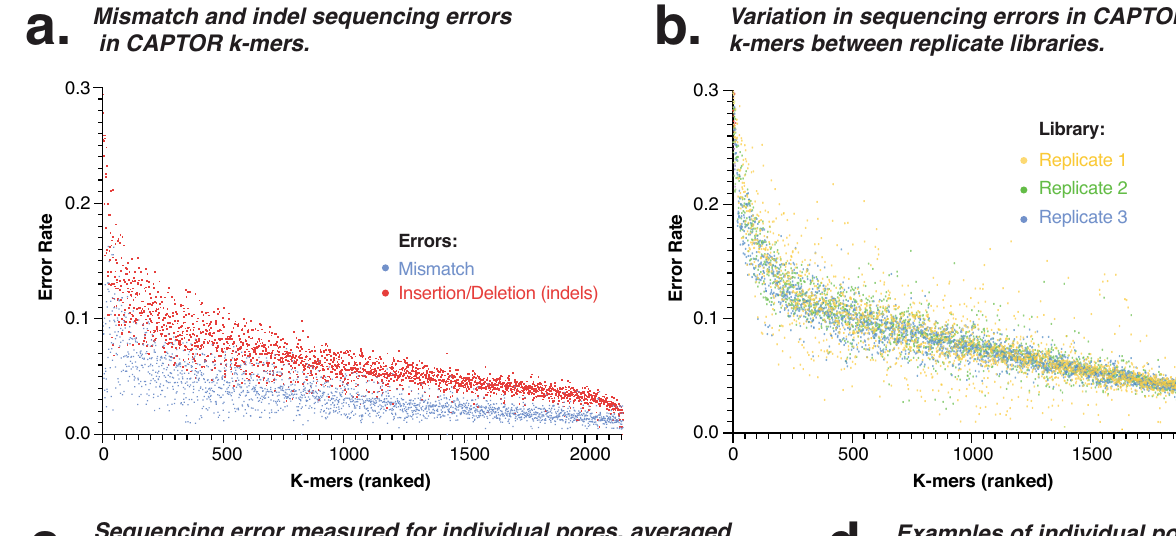
c. Sequencing error measured for individual pores, averaged across a sequencing experiment.